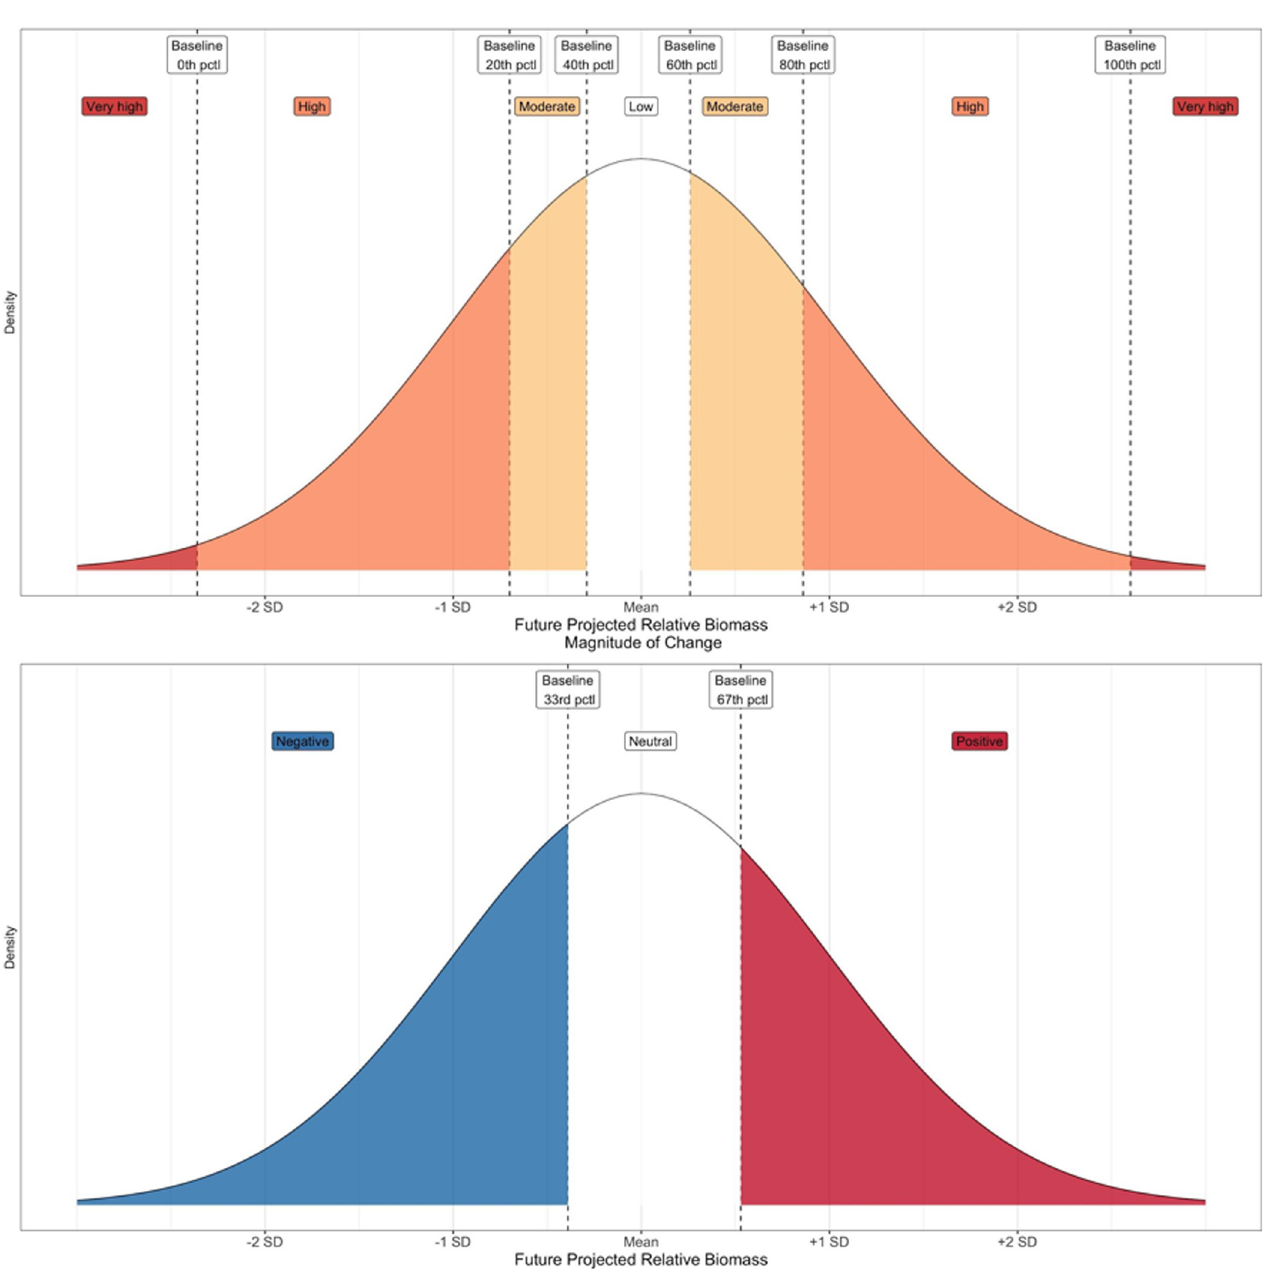
Fig 2. Calculating sensitivity and directional effect bin probabilities. These figures depict how we calculated sensitivity bin probabilities (top figure) and directional effect in probabilities (bottom figure) using baseline predicted relative biomass percentiles and the mean and standard deviation for the future projected relative biomass. For the sensitivity component, we were specifically focusing on the absolute magnitude of change, while for the directional effect component we accounted for the relative change. Color coded shaded regions are used to highlight the total probability of being in each sensitivity bin (very high, high, moderate, low) and directional effect bin (negative, neutral,